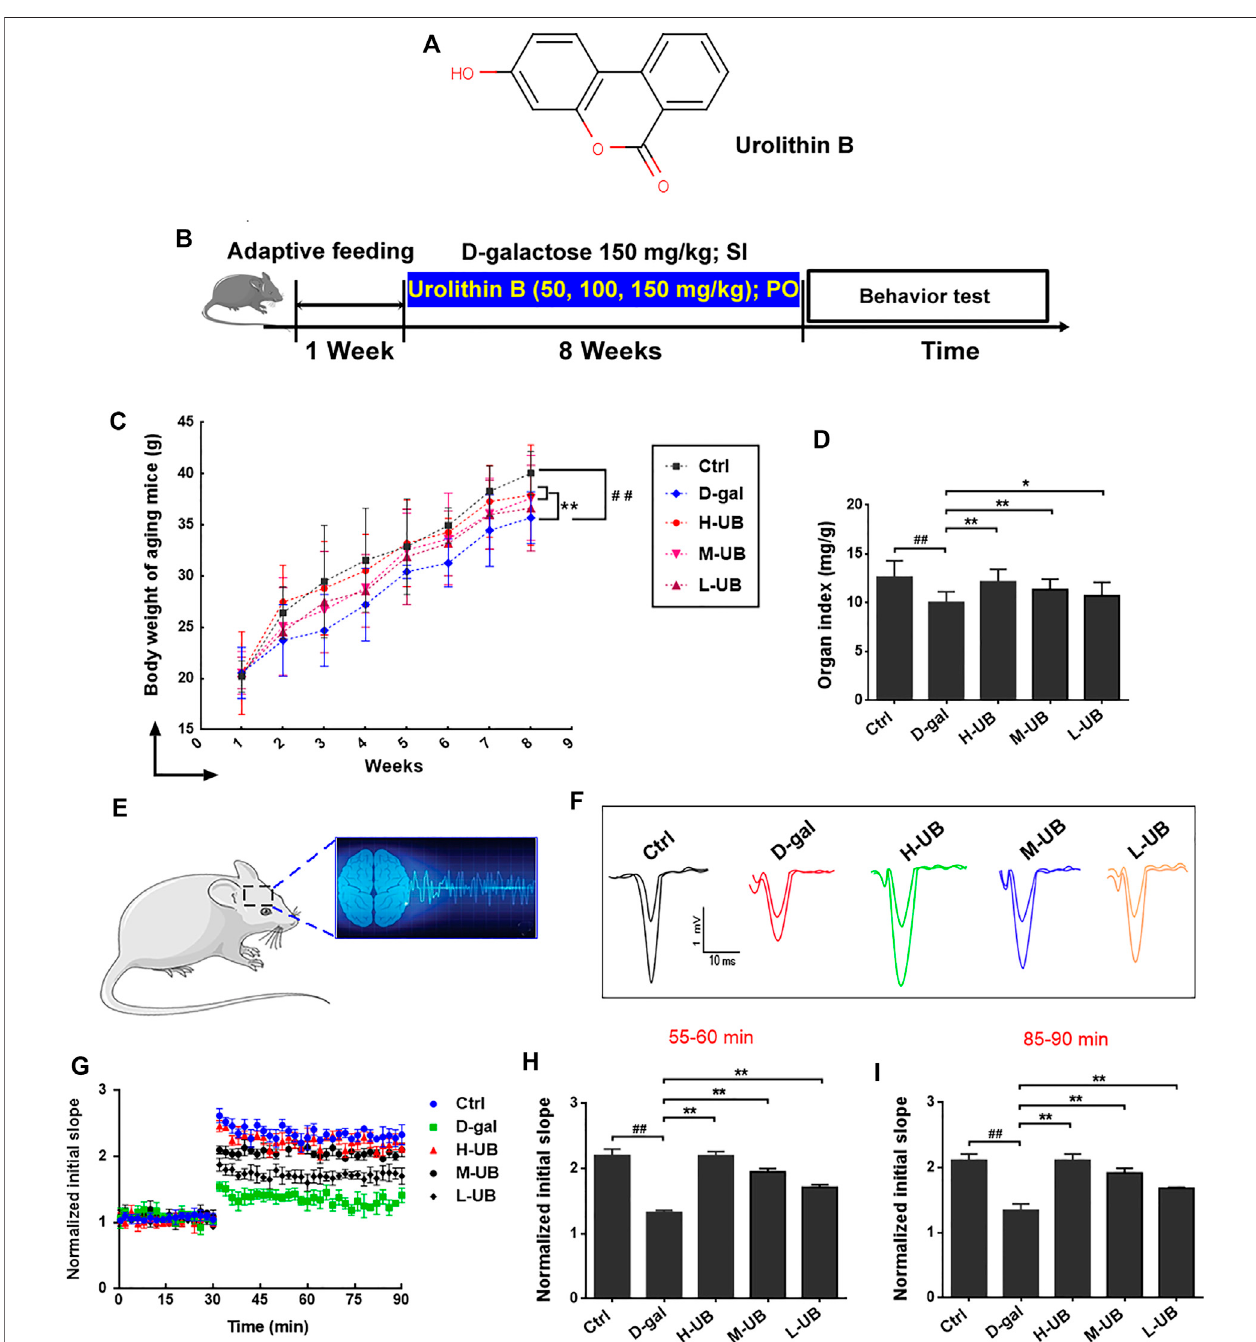
FIGURE2|(A) MolecularstructureofUB. (B) SchematicdiagramoftheexperimentaldesignfortheD-gal-inducedagingmodelandUBtreatment. (C) EffectofUB onbodyweight(C)andbrainindex (D) inallgroups( n (cid:1) 12pergroup). (E) Agraphicaldrawingshowingelectrophysiologicalrecordings. (F) RepresentativefEPSPtraces. (G) The slope of the fEPSP was measured for 90 min. The data represent averaged increases in the slope of the fEPSP at t (cid:1) 55 – 60 (H) and 85 – 90 (I) min relative to baseline ( n (cid:1) 6 per group). All results are described as means ± SD. # p < 0.05 and ## p < 0.01 vs the control group; * p < 0.05 and ** p < 0.01 vs the D-gal-induced aging group. SI: Subcutaneous Injection; PO: Per Oral.